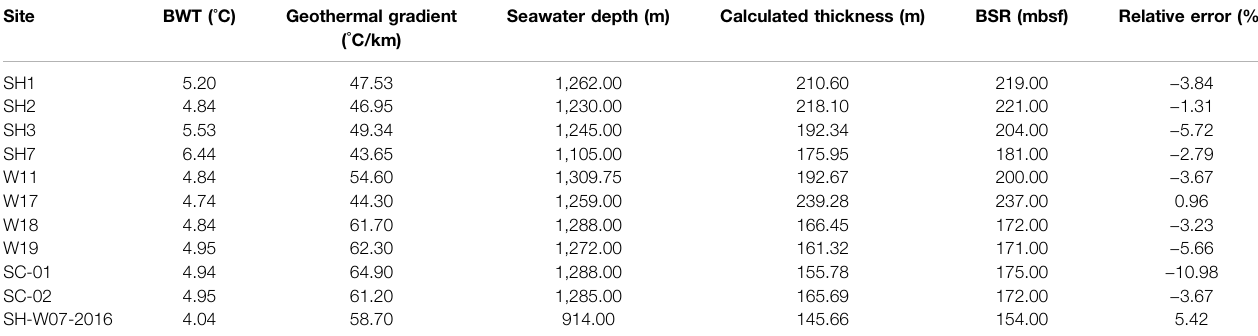
TABLE2| CalculationparametersandresultsoftheGHSZ(BWTdataarefromZhuetal.,2013;Zhangetal.,2020a,Zhangetal.,2020b.Geothermalgradientdataarefrom Su et al., 2016; Zhang et al., 2020a, Zhang et al., 2020b; Jin et al., 2020a. Seawater depth data are from Wang et al., 2014; Zhang et al., 2019; WOA13 V2. Seawater density data are from Wang et al., 2013. BSR data are from Wu et al., 2011; Wang et al., 2014; Su et al., 2016; Liang et al., 2017; Jin et al., 2020a).